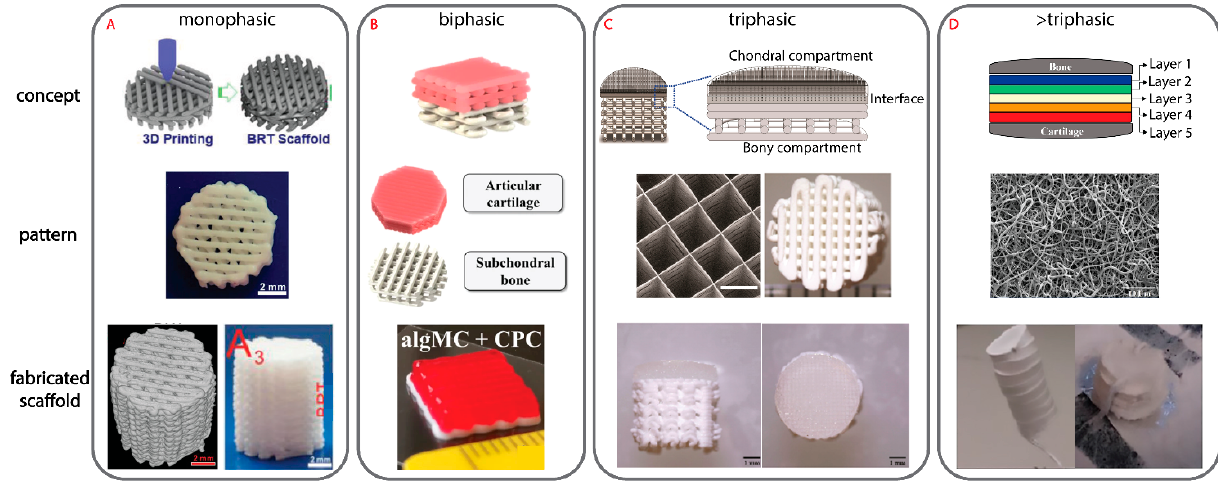
Figure 7. Examples of different scaffold design approaches including the pattern of each 3D printed layer. ( A ) A monophasic scaffold made from a homogenous ceramic paste ME printed. The text in the fabricated scaffold image is from the original research output [196]. ( B ) A biphasic scaffold with both phases ME printed. The subchondral bone phase is made from a ceramic paste and the cartilage phase is made from a hydrogel [109]. ( C ) A triphasic scaffold made from ME and MEW where the subchondral bone phase is made from a ceramic paste, the cartilage phase contains a thermopolymer MEW mesh and hydrogel while the interface contains all the forementioned materials [105]. ( D ) A >triphasic scaffold has more than three distinct phases with this example scaffold containing five individual phases all made from ES